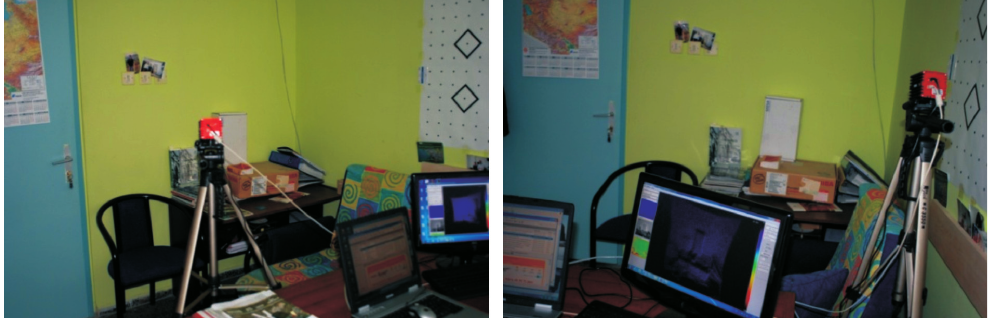
Fig. 1. SR4000 camera stations and measurement side (case study 1)